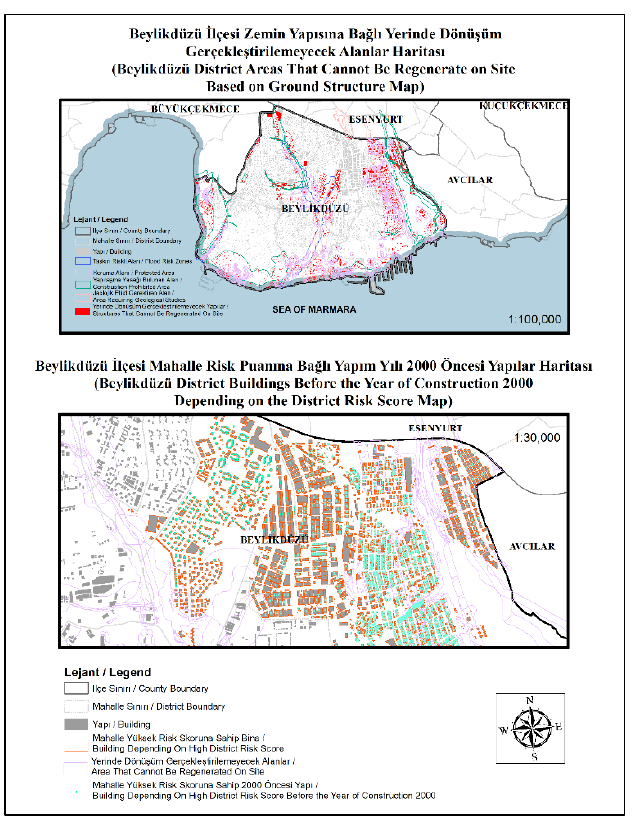
Figure 20. ‘Beylikdüzü District Areas That Cannot be Regenerate Based on Ground Structure Map’ and ‘Beylikdüzü District Buildings before the Year of Construction 2000 Depending on District Risk Score Map’ .